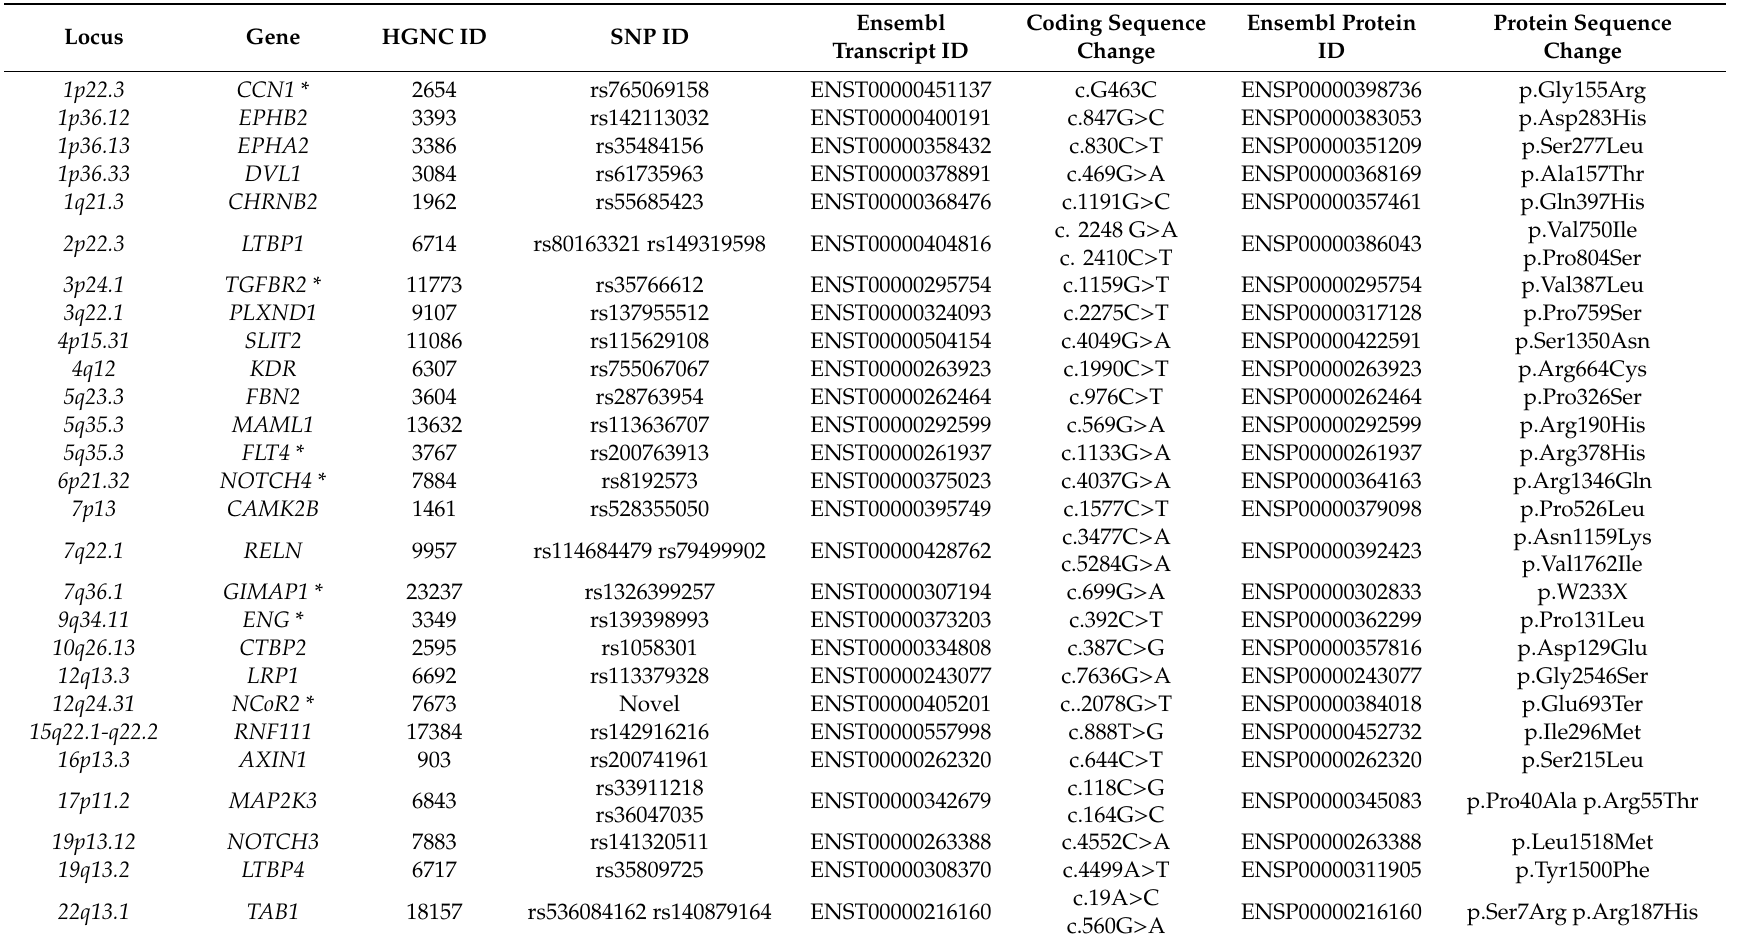
Table 3. Variants a ff ecting prioritized